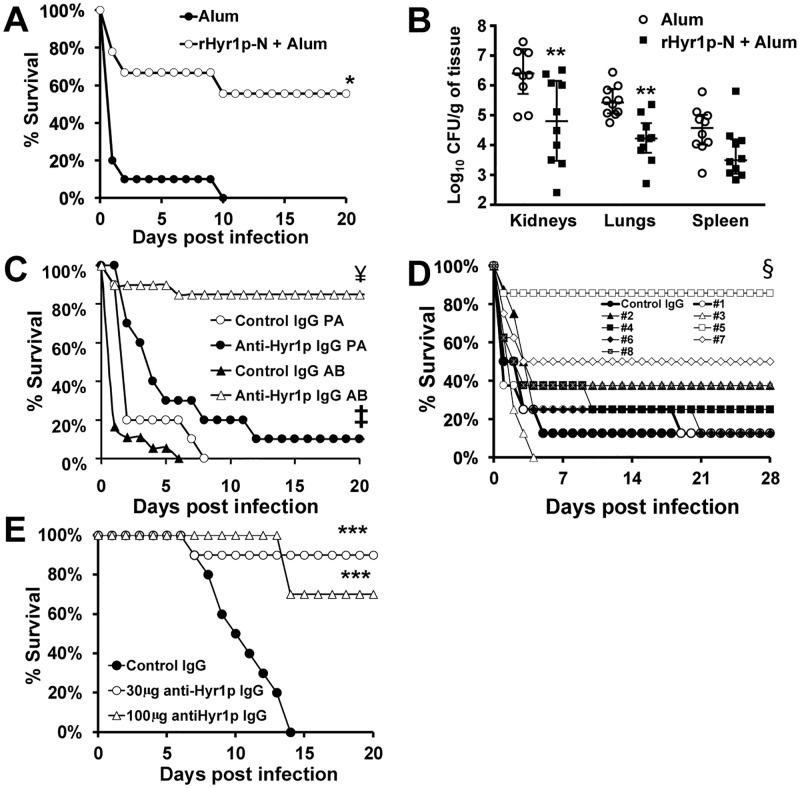
Active or passive immunization targeting Hyr1p protect diabetic and neutropenic mice from A. baumannii infections.Survival of diabetic mice (n = 10 for alum control or 9 for rHyr1p-N + Alum) were vaccinated and boosted with 30 μg dose mixed with 0.1% aluminum hydroxide then infected with A. baumannii HUMC1 (confirmed inoculum of 2.5 x 107) via the tail vein. *P = 0.005 vs. alum control (A). Tissue bacterial burden of target organs harvested from diabetic mice (n = 10 per arm) vaccinated with alum or rHyr1p + alum three days after infecting with A. baumannii (5 x 106). **P <0.02 vs. alum vaccinated mice (B). Survival of diabetic mice that were given an intraperitoneal (i.p.) injection of 1 mg of pooled anti-Hyr1p IgG raised against 8 individual peptides of Hyr1p (n = 20 from 2 independent experiments with similar results for A. baumannii [AB] infection and 10 for P. aeruginosa [PA]) or control IgG (n = 18 for AB and 10 for PA) 2 hours prior to infecting them intravenously (i.v.) with AB or PA (confirmed inocula of 3.4 x107 cells for AB and 1.1 x 108 for PA). ¥P = 0.00001 vs. Control IgG of AB ‡P = 0.1 vs. Control IgG of PA (C). Survival of diabetic mice (n = 8 per group) that were given an i.p. injection of 1 mg of each anti-Hyr1p IgG raised against individual peptides of Hyr1p 2 hours prior to infecting them i.v. with A. baumannii (confirmed inoculum of 6.2 x 107). §P <0.05 vs. all arms except peptide, 2, 7, or 8 (D). Survival of neutropenic mice (n = 10 per group) infected with A. baumannii via inhalation (inhaled inoculum of 2.2 x 107) and 24 h later treated i.p. with either isotype matching control IgG (100 μg), or with anti-peptide 5 IgG (at 30 or 100 μg). A repeat dose of the antibody was given on Day +8. ***P <0.002 vs. Control IgG arm (E).